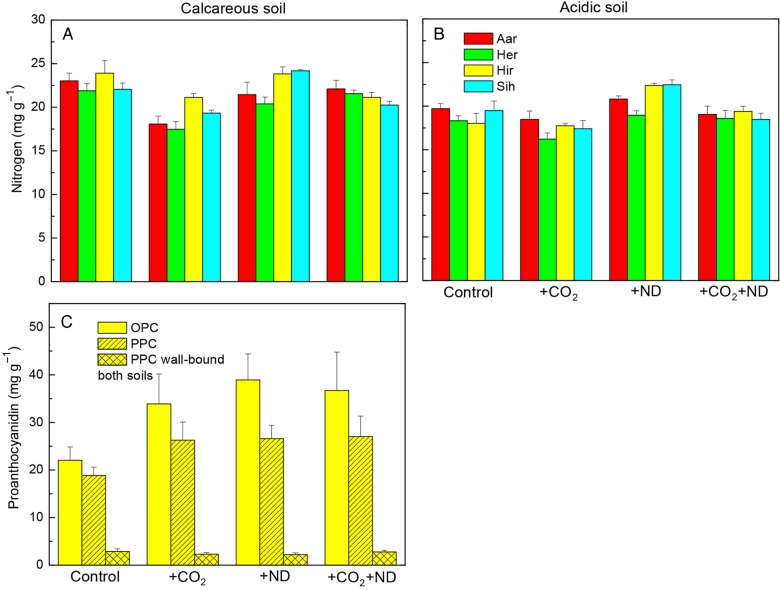
The change in the concentration of nitrogen (A and B) and PC (C) oligomers (OPC) and polymers (PPC) in September in response to +CO2, +ND and +CO2 + ND versus control, within the foliage of several origins of beech (C: Hir only) growing on either the acidic or calcareous forest soil (C: soil types without effect, data pooled); mean values + SE, A and B: N = 4, C: N = 8).